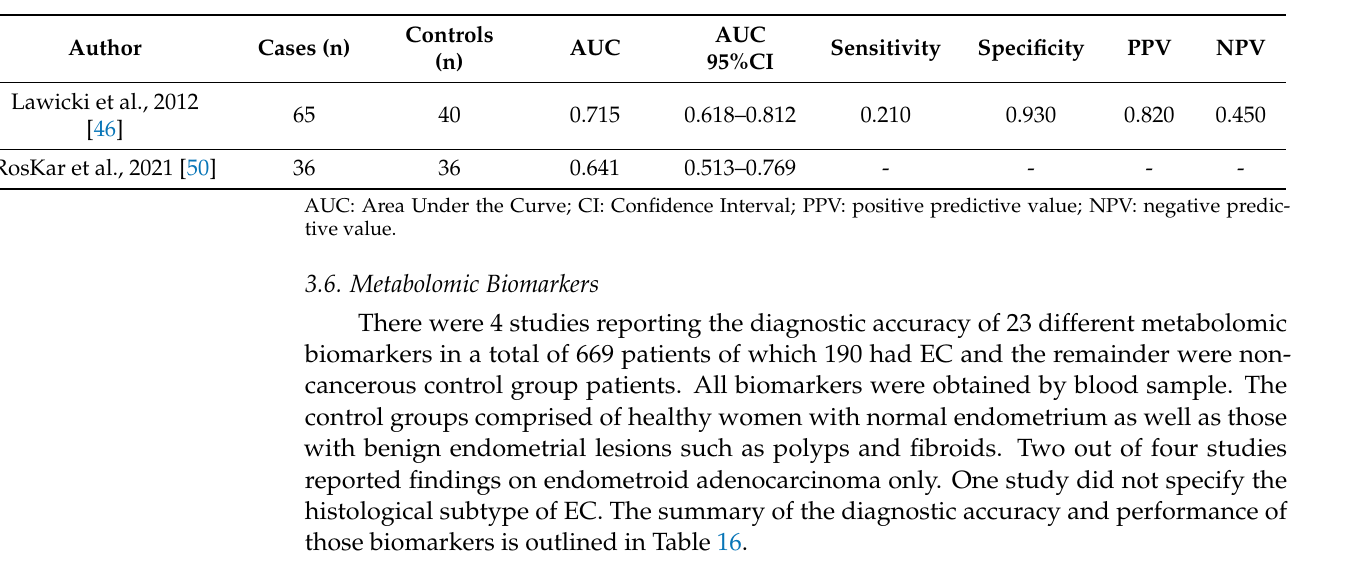
Table 15. Summary table of the performance of G-CSF.